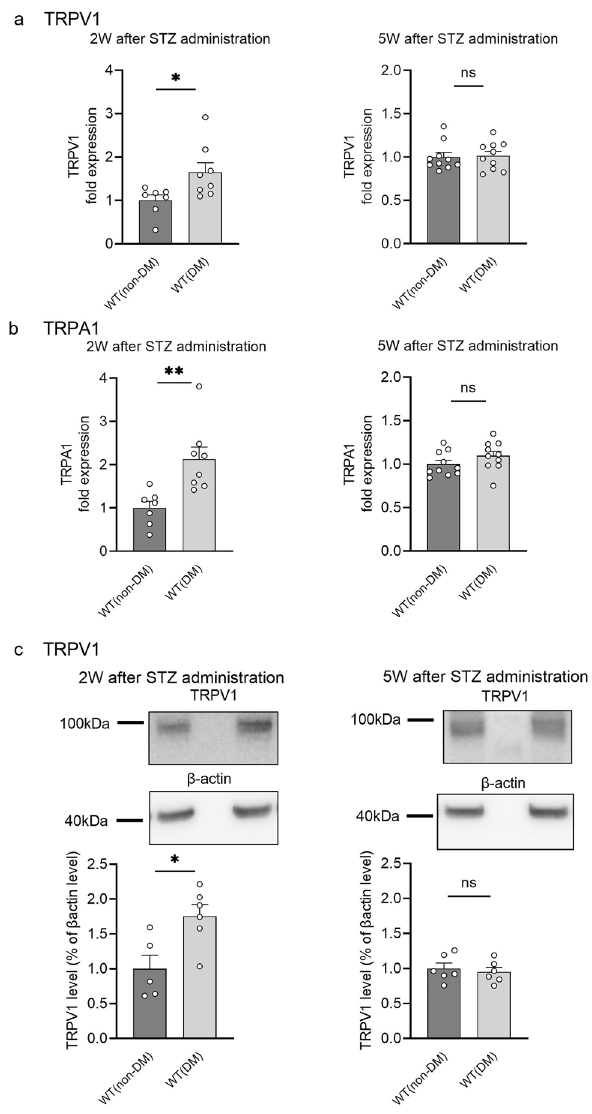
Figure 3. Expression of TRPV1 and TRPA1 in the dorsal root ganglia of mice 2 and 5 weeks after STZ administration. ( a,b ) mRNA expression levels of TRPV1 ( a ) and TRPA1 ( b ) in dorsal root ganglia (DRG) at 2 (left) and 5 (right) weeks after STZ administration. We used 36B4 as a housekeeping gene to normalize the expression. WT (non-DM), n = 7–10. WT (DM), n = 8–10. ( c ) Comparison of protein levels of TRPV1 in DRG by western blot analysis at 2 (left) and 5 (right) weeks after STZ administration. We used β-actin as an internal loading control. The predicted molecular weights of TRPV1 and β-actin are 95 and 42 kDa, respectively. WT (non-DM), n = 5–6. WT (DM), n = 6. The data are presented as the means ± SEM. A two-tailed t test was used for comparisons. * p < 0.05 and ** p < 0.01. ns = not significant. Open circles indicate